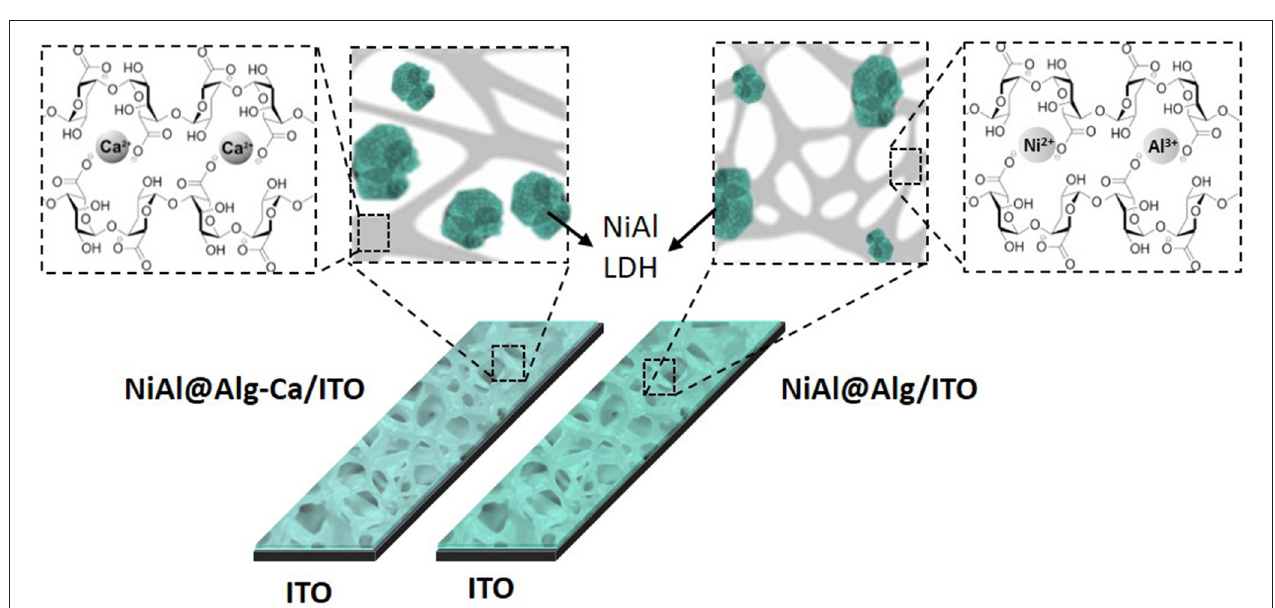
Frontiers in Chemistry |